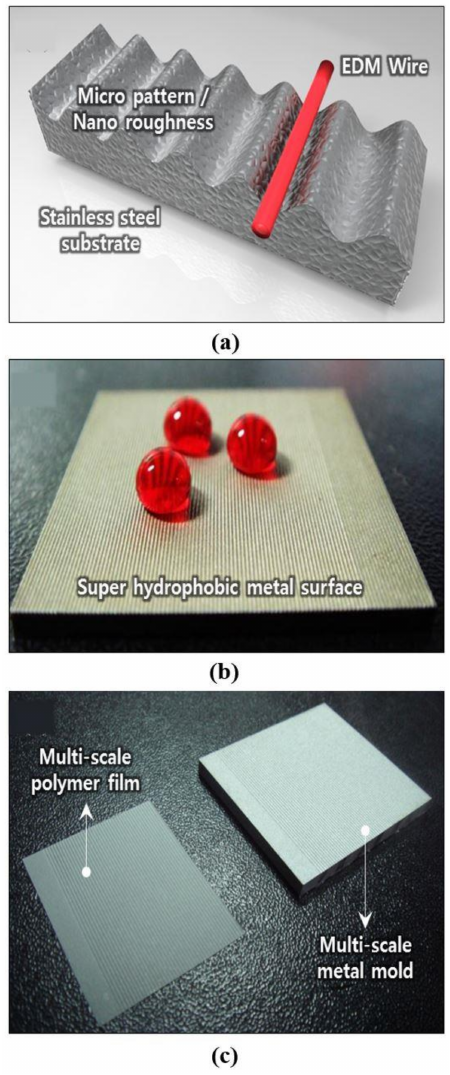
Figure 3. ( a ) Schematic diagram of fabrication of dual-scale structures on metallic surfaces by WEDM. Through single-step machining of sinusoidal patterns, an additional roughness is spontaneously generated owing to its surface exfoliation process; ( b ) Photograph of the multi-scale patterned aluminum surface demonstrating superhydrophobic properties ( λ = 500 µ m, Amplitude: 74 µ m, Roughness ( R a ): 4.16 µ m); ( c ) To explain the concept, photograph of a replicated polymer film with multi-scale